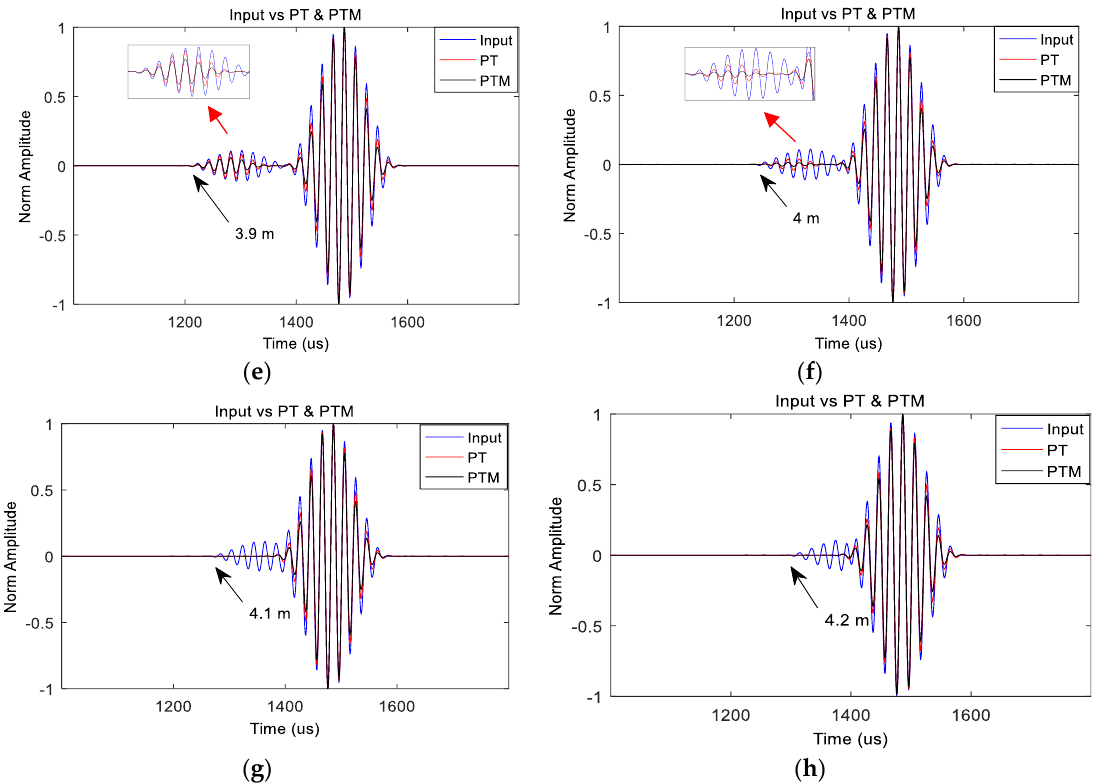
Figure 6. Results for the synthesised signal before and after applying SSP (PT & PTM). The defect (X = 3.5 m) is moved towards the pipe end (X = 4.5 m) in steps of 0.1 m. The defect distances are X= ( a ) 3.5 m; ( b ) 3.6 m; ( c ) 3.7 m; ( d ) 3.8 m; ( e ) 3.9 m; ( f ) 4 m; ( g ) 4.1 m; ( h ) 4.2 m.